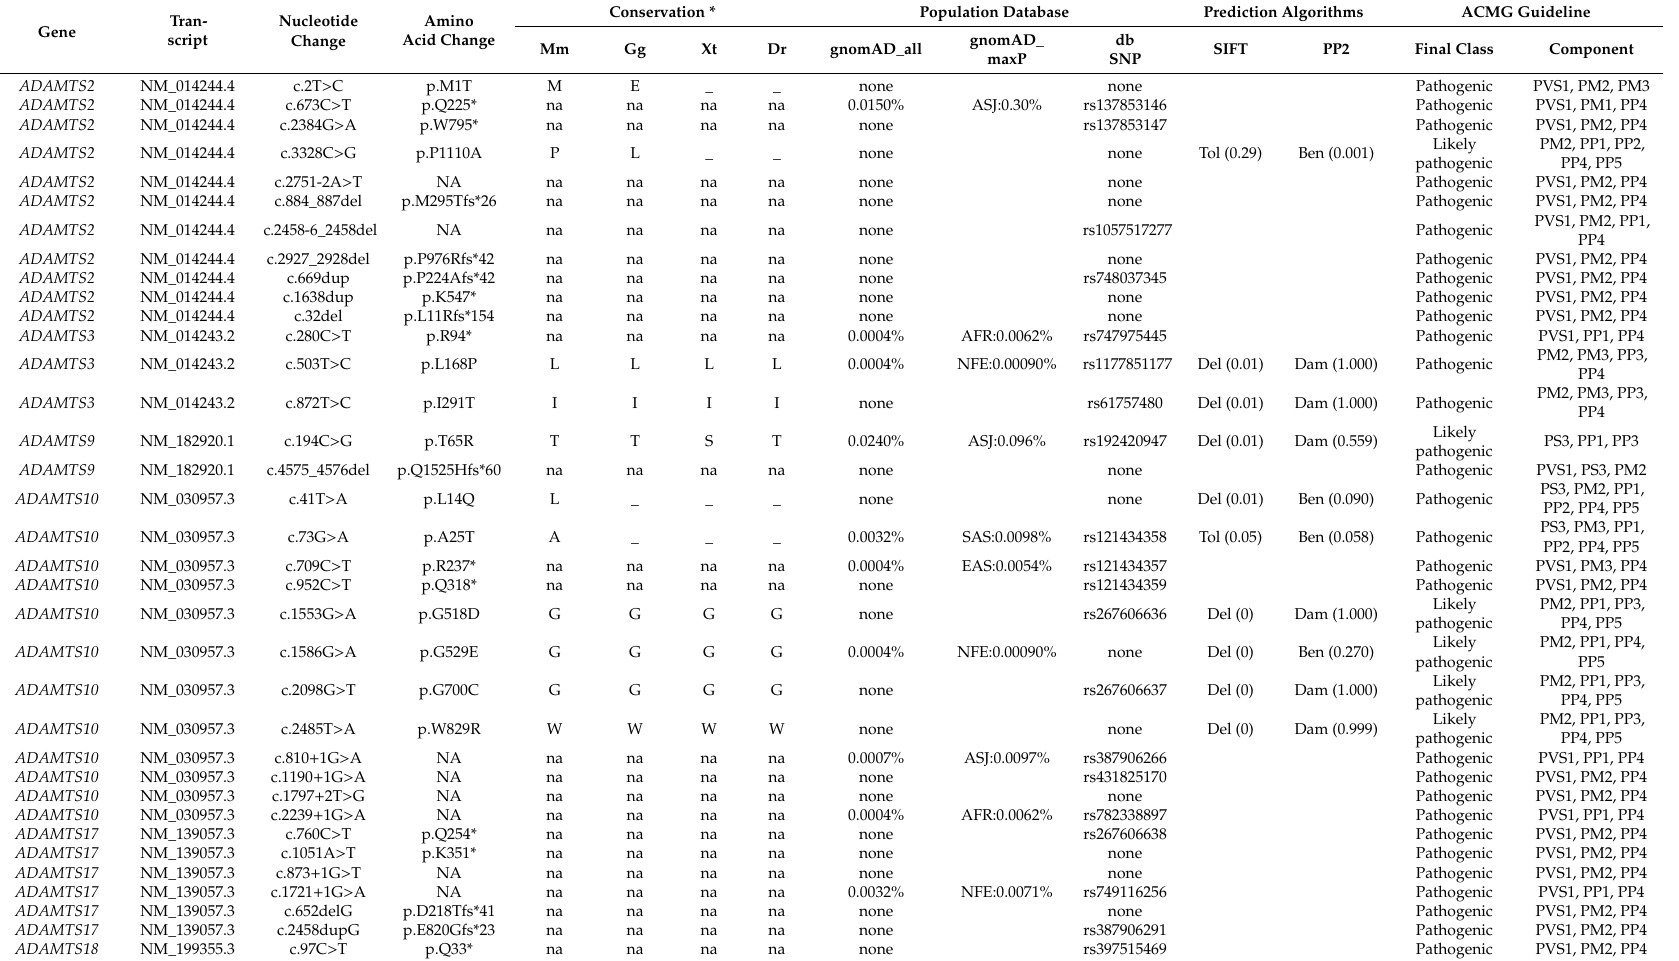
Table 4. Reassessment of previously reported pathogenic mutations in ADAMTS family genes using the American College of Medical Genetics and Genomics (ACMG) variant interpretation